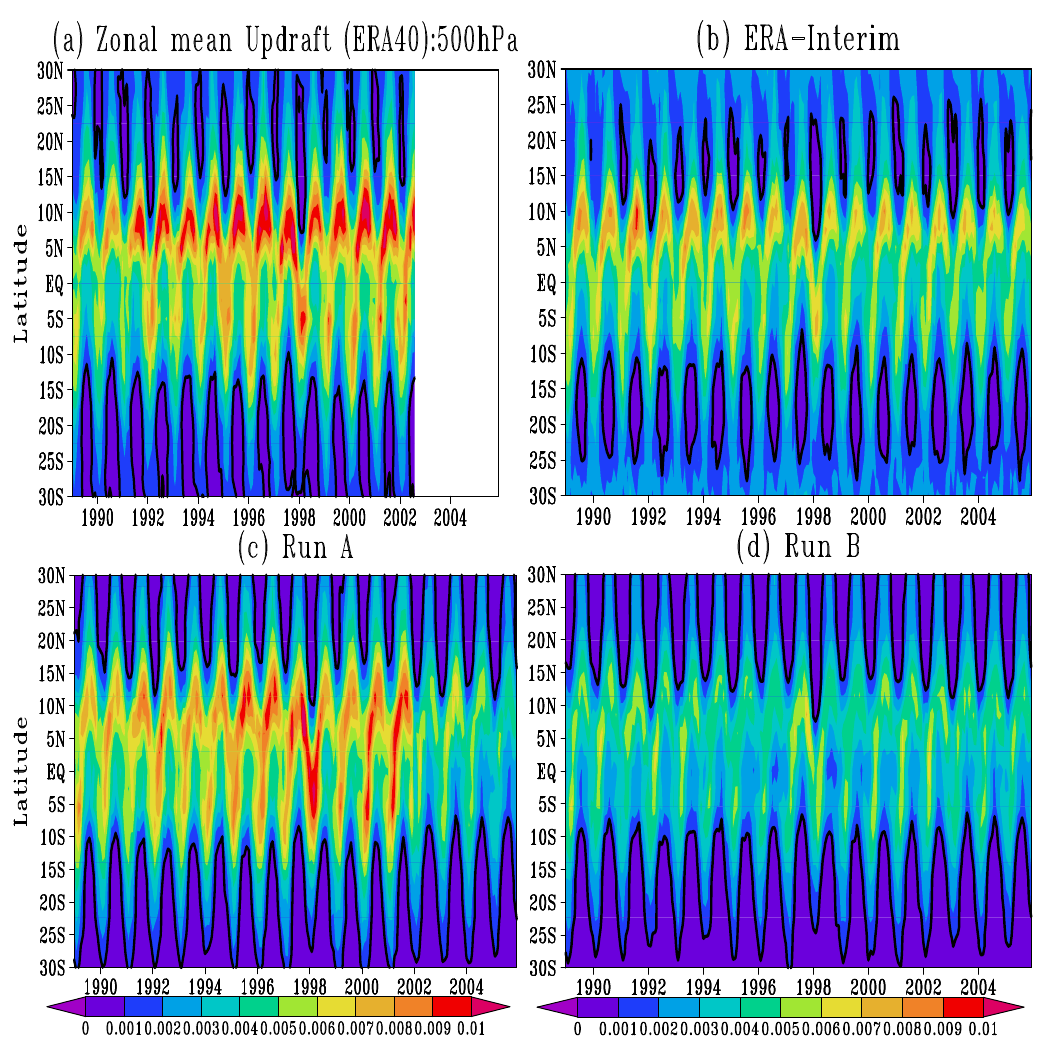
Fig. 2. Time series of zonal mean monthly mean updraft convective mass flux (kgm − 2 s − 1 ) at 500hPa from (a) ERA-40 reanalyses, (b) ERA-Interim reanalyses, (c) Run “A E40” (forced by operational winds from 2002 onwards), and (d) Run “B EI”. The bold contour indicates 0.001kgm − 2 s − 1 .